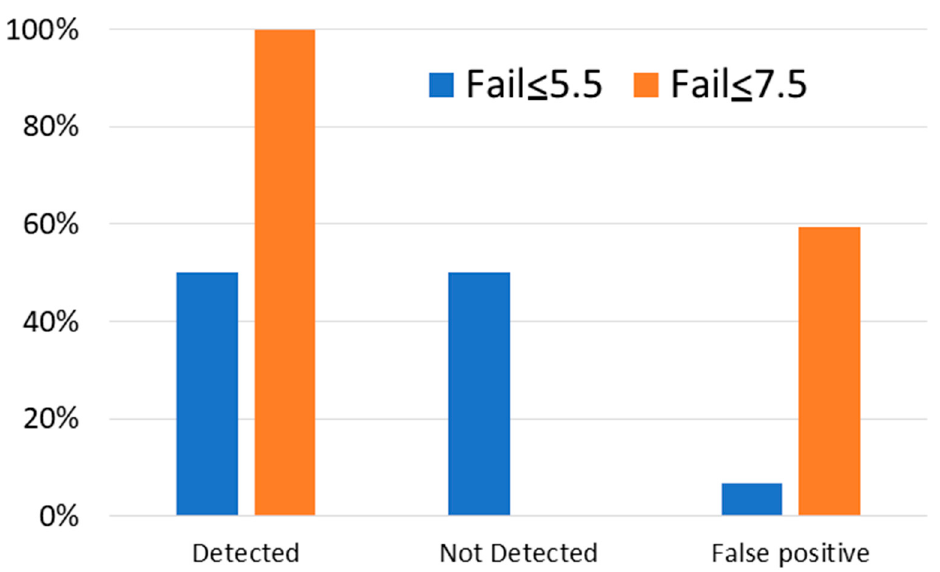
Figure 6. Classification task focusing on the detection of students at risk of failure, excluding data from the last month.